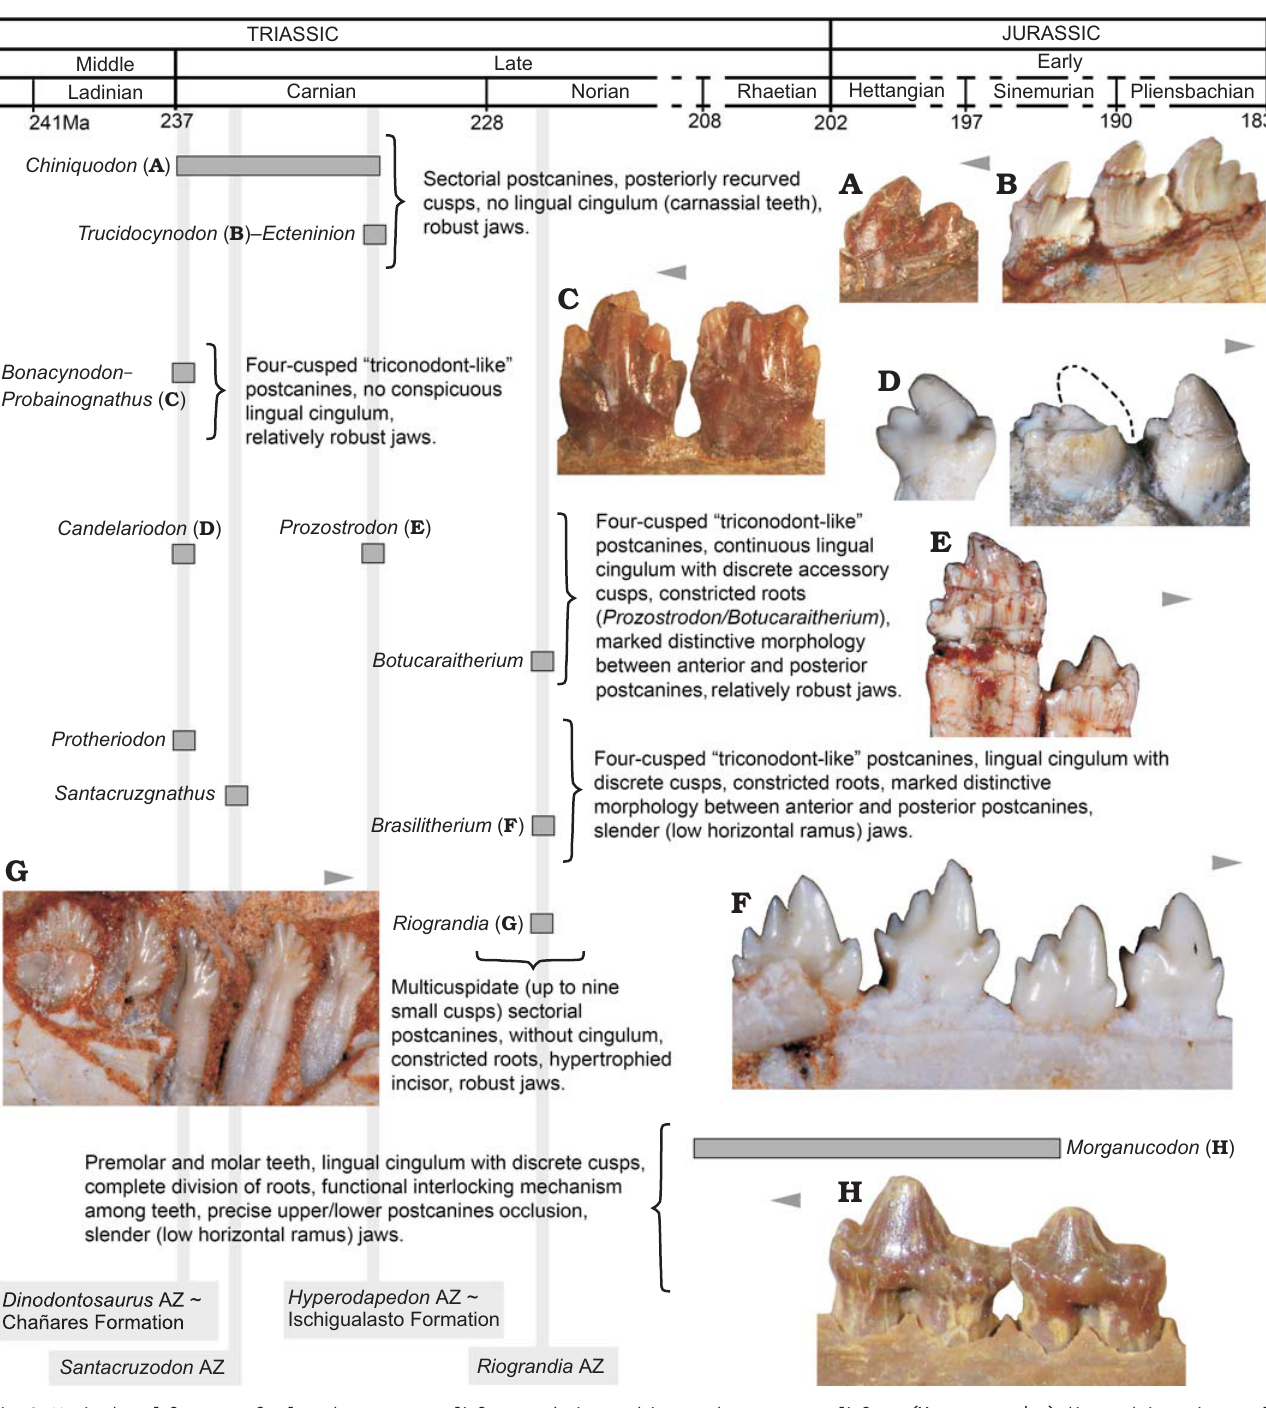
Fig. 8. Main dental features of selected non-mammaliaform probainognathians and one mammaliaform ( Morganucodon ) disposed in a time scale. A . Chiniquodon theotonicus , PVL 4444, left lower postcanine in labial view. B . Trucidocynodon riograndensis , UFRGS-PV-1051-T, left lower postca- nines in labial view. C . Probainognathus jenseni , PVL 4445, right lower pc5–6 in lingual view. D . Candelariodon barberenai , MMACR PV-0001-T, left lower postcanines in lingual view. E . Prozostrodon brasiliensis , UFRGS-PV-0248-T, left lower postcanines in labial view. F . Brasilitherium quadrangu- laris , UFRGS-PV-0603-T, left lower postcanines in labial view. G . Riograndia guaibensis , UFRGS-PV-0833-T, left lower postcanines in lingual view. H . Morganucodon watsoni , NHMUK-PV-M-U273, right postcanines in lingual view. Arrows indicate mesial side of the